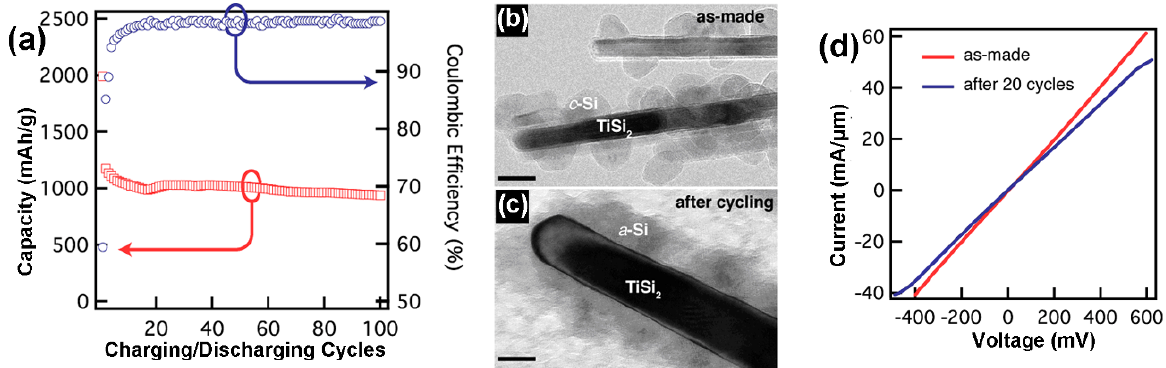
heterostructure as anode for Li ion battery [26]. Figure 11. Performance of Si/TiSi 2 (a) Charge capacity and Coulombic efficiency of the Si/TiSi hetero-nanostructure 2 with 8,400 mA/g charge/discharge rate tested between 0.150 and 3.00 V. (b-c) The TiSi 2 core remained intact during the test, while the as-made crystalline Si coatings became amorphous after cycling. Scale bars: 20 nm. (d) The electrical conductivity remained high core was preserved. Reproduced after cycling, further indicating the property of the TiSi 2 with permissions from American Chemical Society